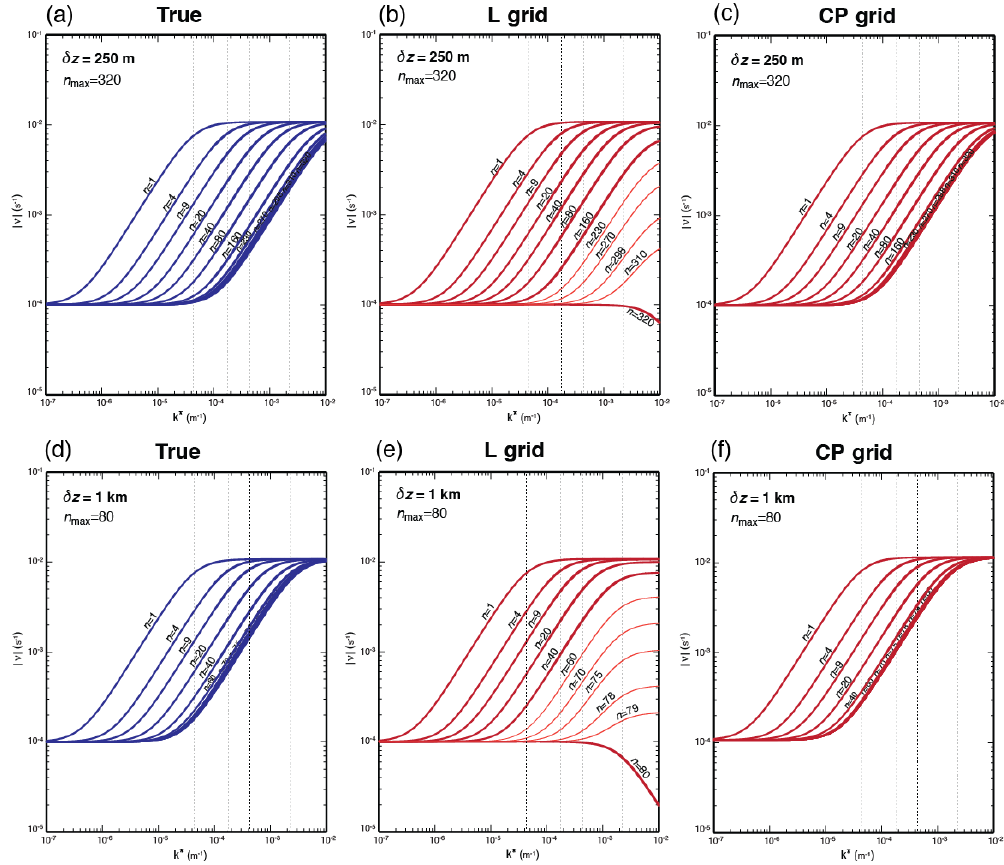
Figure 11. Plots of (a, d) true frequencies and discrete frequencies for the (b, e) L and (c, f) CP grids. The upper and lower panels show the plots for the maximum vertical integer wavenumbers of n max = 320 ( δz = 250m) and n max = 80 ( δz = 1km),